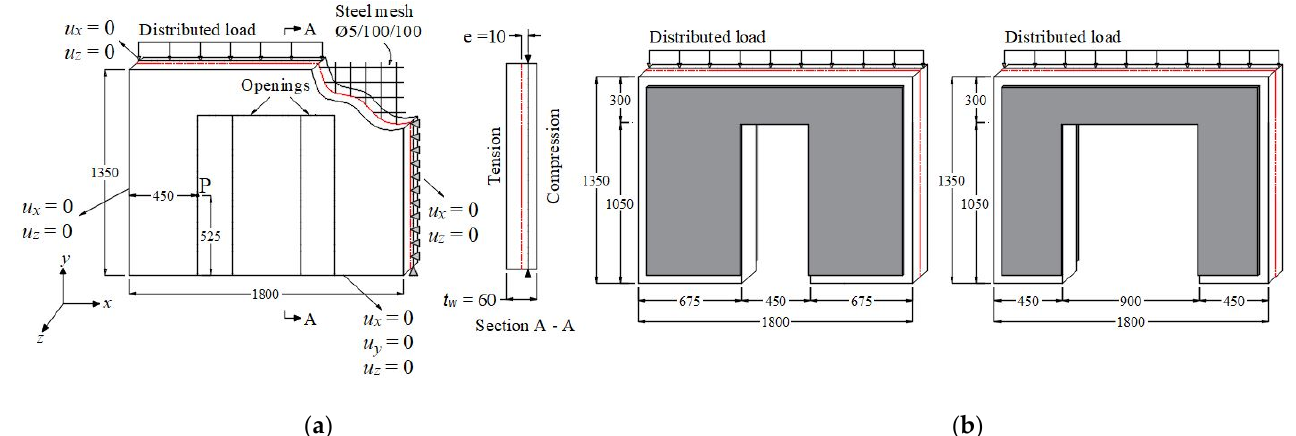
Figure 1. Dimensions, reinforcement details, and boundary conditions: ( a ) control walls according to Popescu et al. [3]; ( b ) TRM strengthened walls according to Sabau et al. [19]. (Unit: mm).